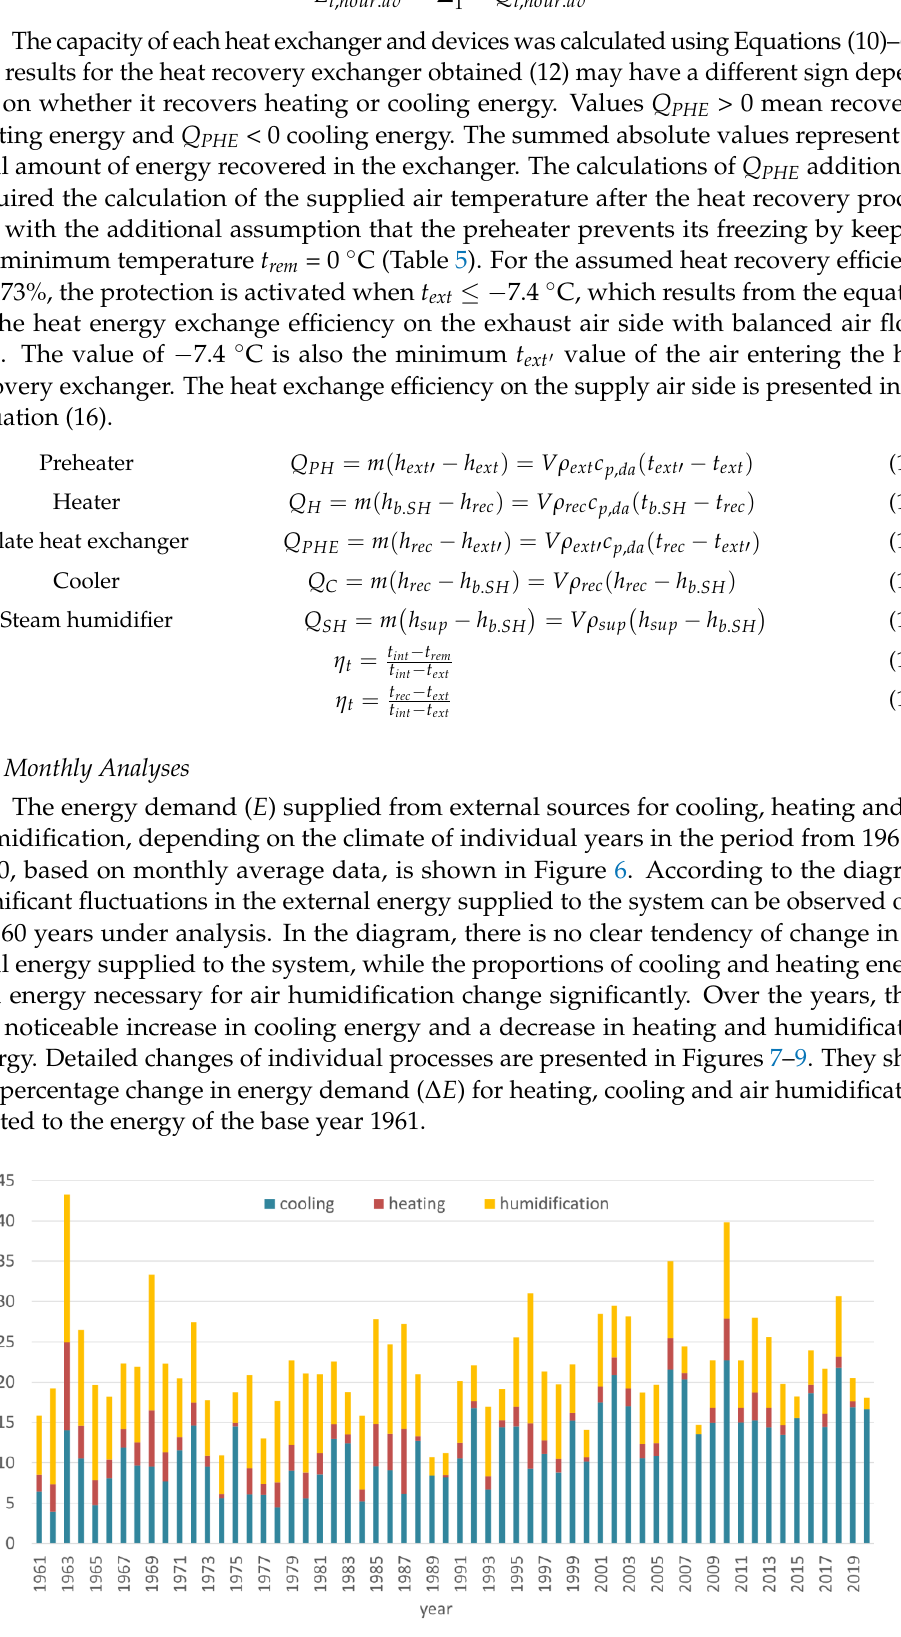
Figure 6. External energy supplied to the system to treat 1000 L/s of primary air.